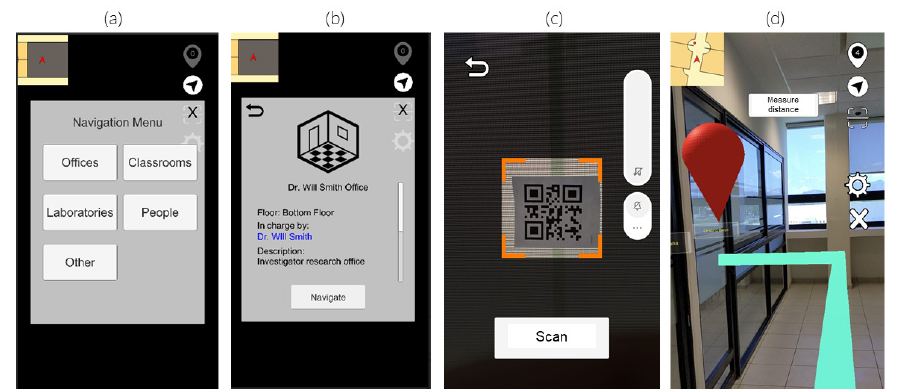
Figure 4. Developed application’s interfaces examples. ( a ) POI types menu, ( b ) POI contextual information, ( c ) QR scanning interface, ( d ) AR line for path